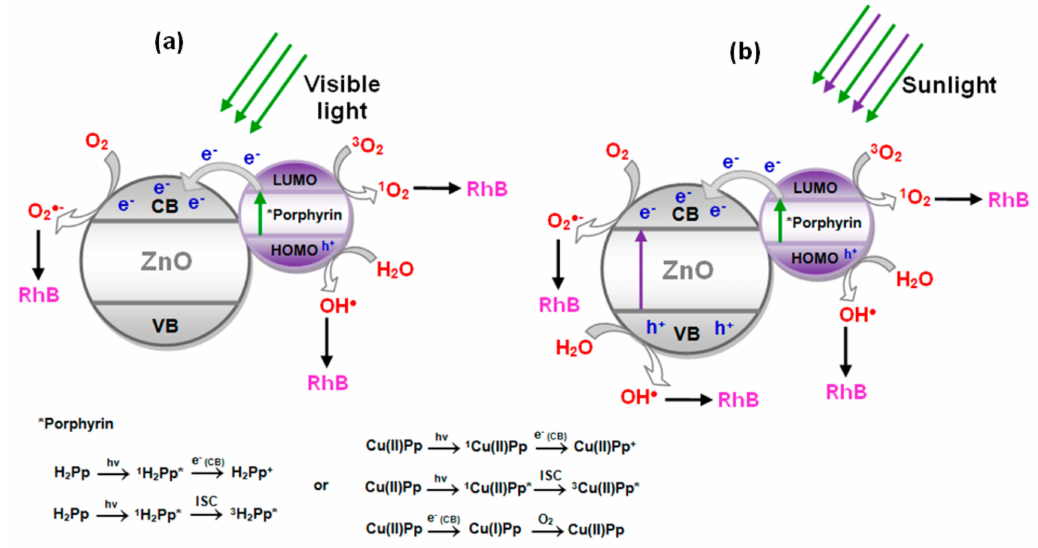
Figure 7. Proposed mechanism for reactive species formation by photocatalysts under visible light ( a ) and natural sunlight ( b